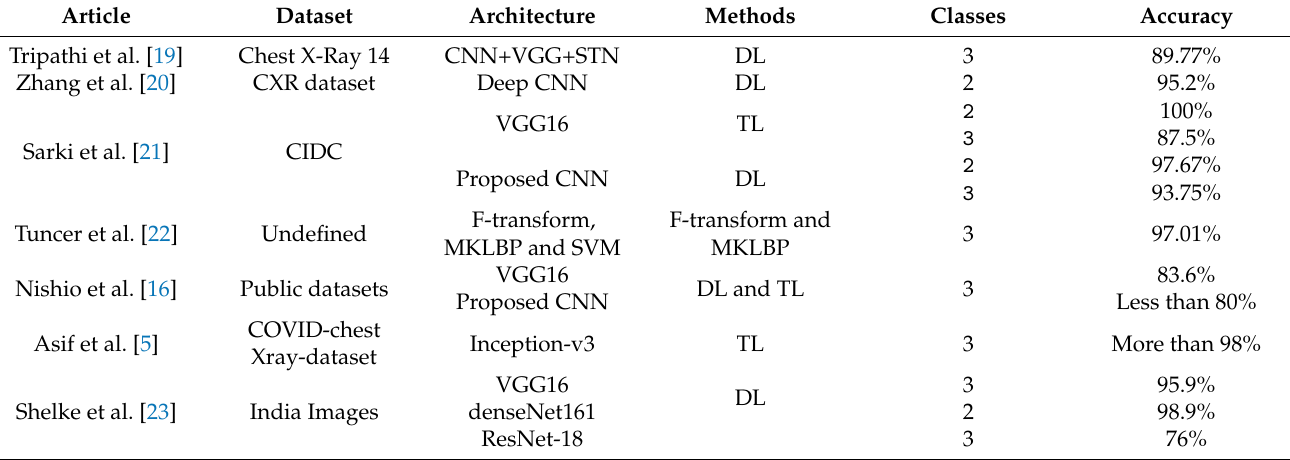
Table 1. Datasets, architectures, methods and accuracy of X-ray-based